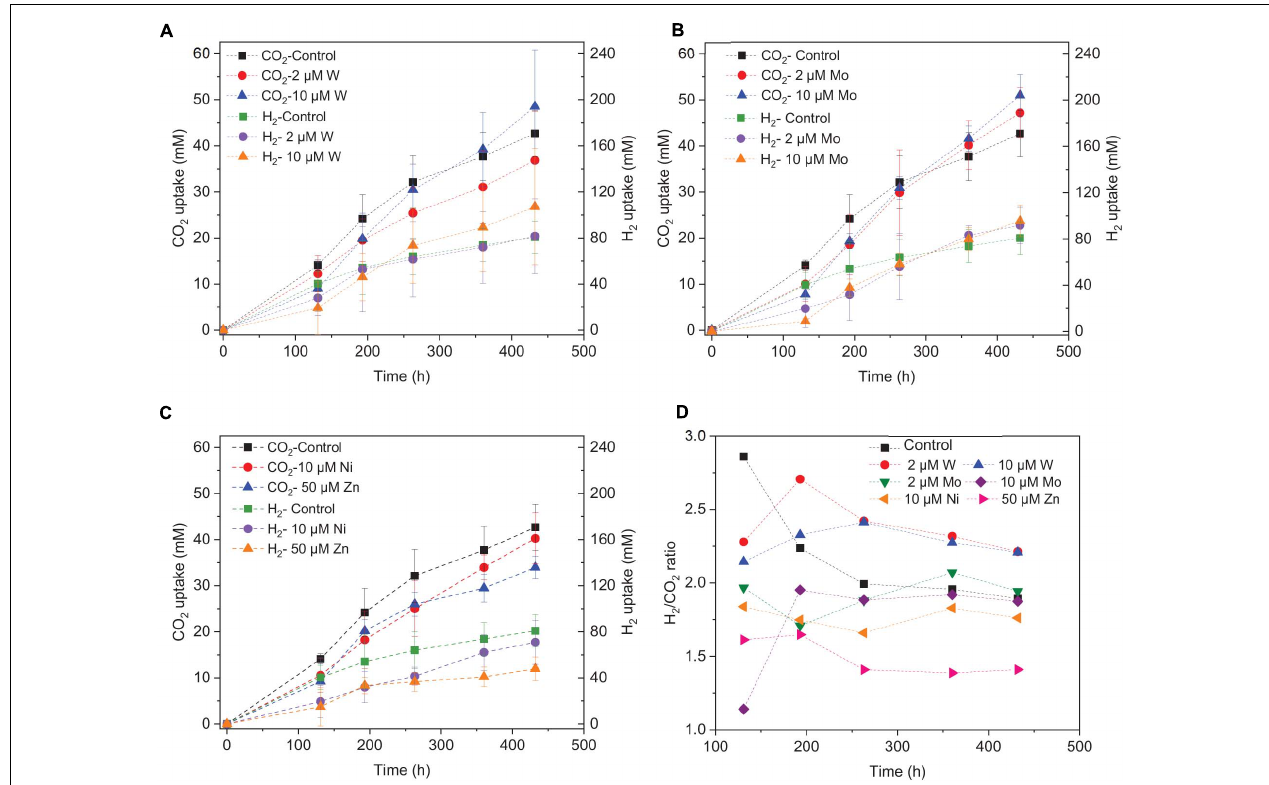
FIGURE 6 | H 2 and CO 2 uptake with the addition of (A) 2 µ M, 10 µ M Mo, (B) 2 µ M, 10 µ M W, (C) 10 µ M Ni, 50 µ M Zn, and (D) H 2 /CO 2 uptake ratio by heat-treated granular sludge using H 2 /CO 2 as the substrate at 25 ◦ C with initial pH